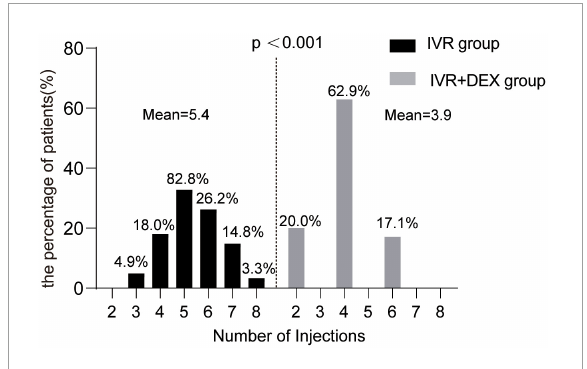
FIGURE6 Number of injections received by RVO subgroups in 12 months.